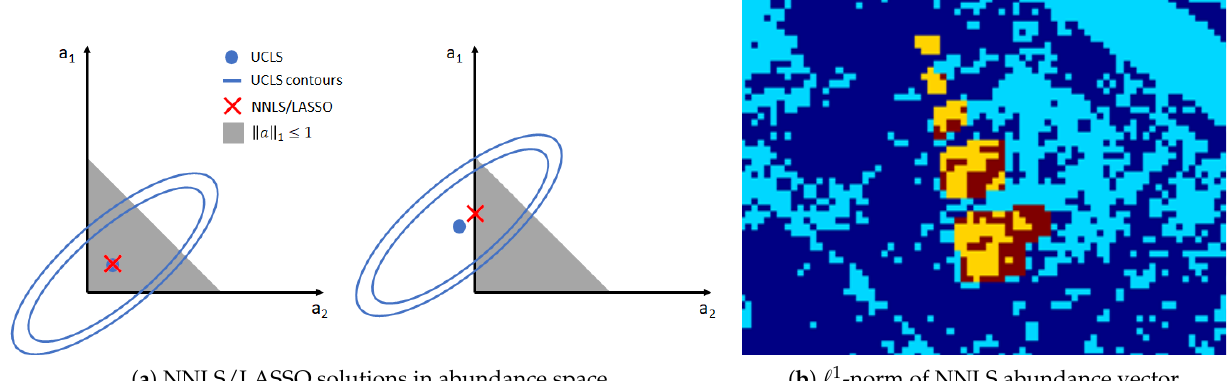
Figure 18. Equivalence of NNLS and LASSO ( λ = 1) abundance estimation framework. The left panel ( a ) illustrates a toy example for NNLS and LASSO ( λ = 1) solutions in an abundance space spanned by two endmembers only. The UCLS solution and corresponding square error contours are shown in blue, while the abundance vector found by NNLS and LASSO is marked with a red cross. In both cases the NNLS and LASSO find the same solution since the LASSO constraint λ = 1 is satisfied. The right panel ( b ) indicates the pixels in the DLR HySU benchmark with an abundance vector x (cid:107) (cid:107) 1 ≤ found by NNLS with 1 in dark blue (yellow in the area surrounding the targets) and with x (cid:107) (cid:107) 1 ≤ (red in the area surrounding the targets). Yellow pixels highlight target pixels with ( λ = 1) are equivalent. Except for the 0.5m red fabric target, all pixels corresponding to the 0.5 and 0.25m targets are yellow in the right panel ( b ), therefore explaining the exact same estimated areas for these targets with NNLS and LASSO ( λ = 1) in Table